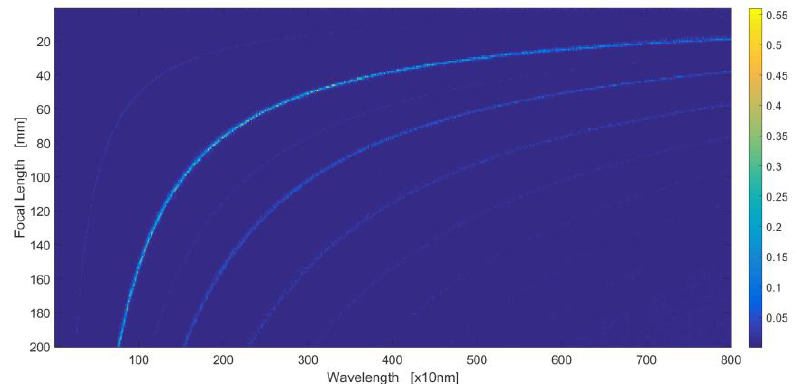
Figure 4. Lens ARESR plotted as function of